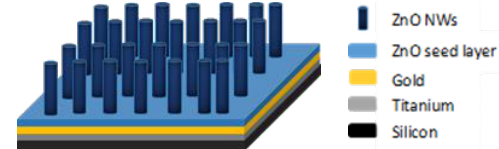
Figure 2. Ideal structure of the sample after hydrothermal growth of ZnO nanowires (NWs).